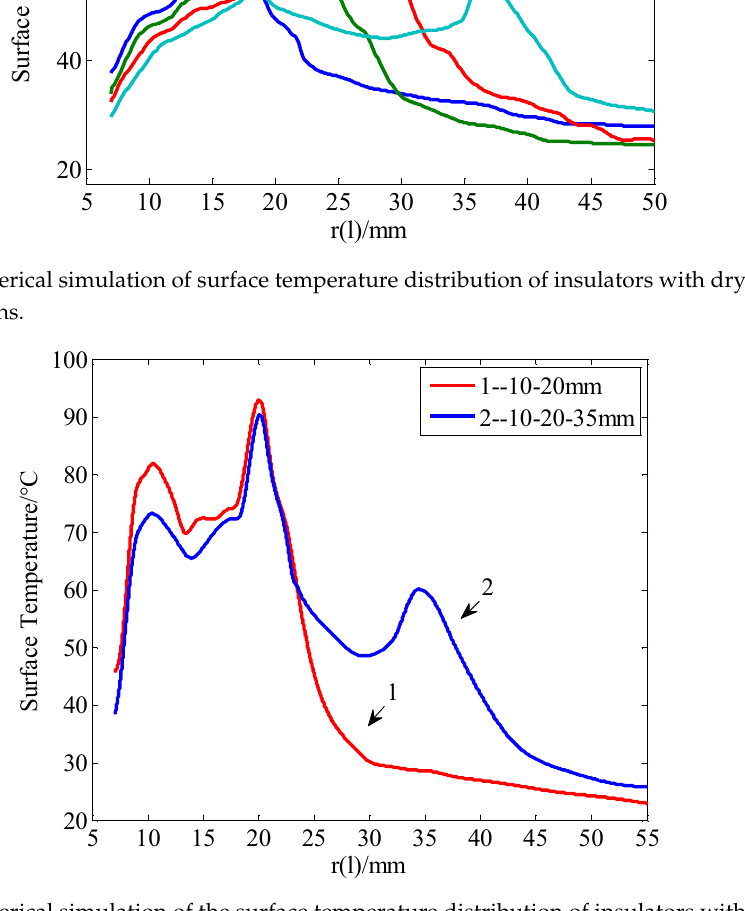
Figure 12. Numerical simulation of the surface temperature distribution of insulators with di ff erent numbers of dry